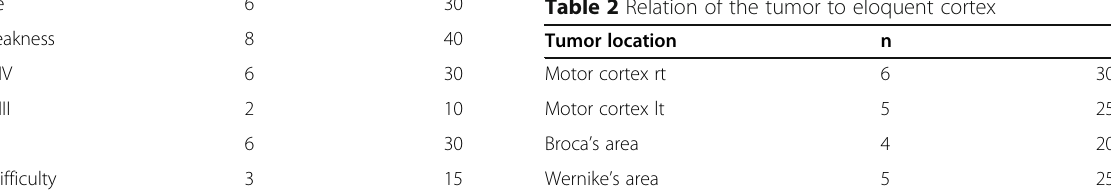
Table 1 Distribution of clinical presentation Clinical picture